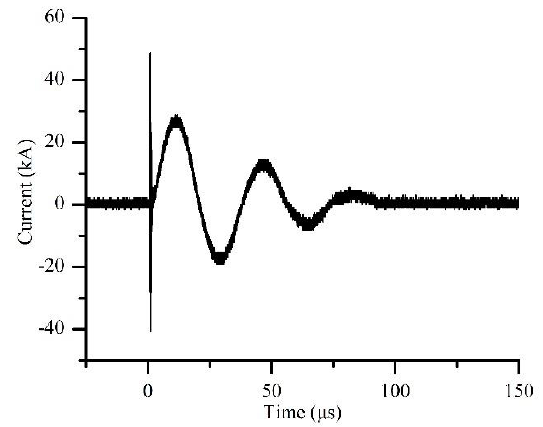
Figure 5. Current waveform of rock fracturing by PHVD.